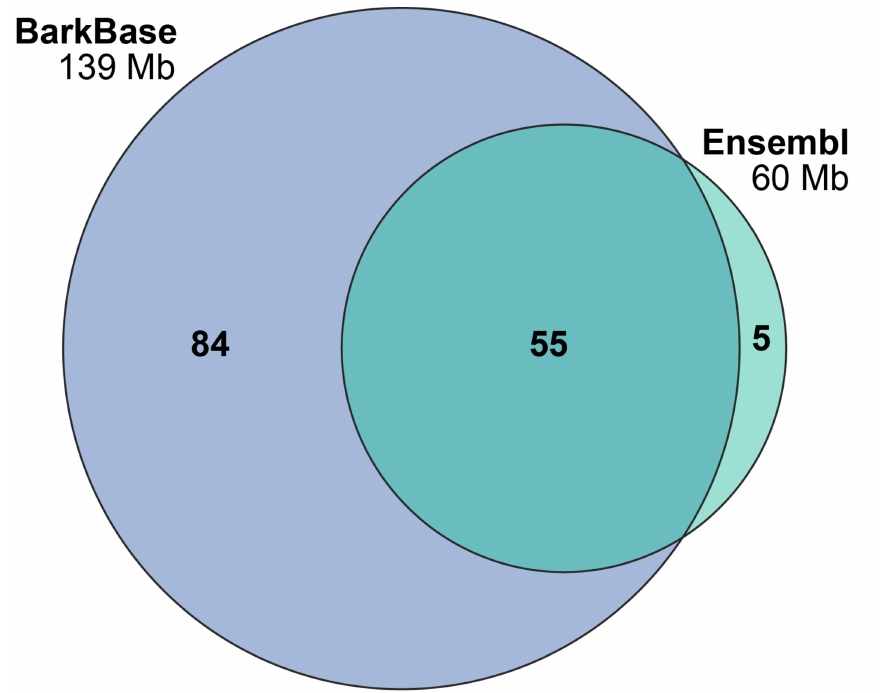
Figure 3. BarkBase captures novel transcripts. Overlapping the transcriptome from BarkBase and Ensembl shows most bases are captured in both datasets. BarkBase contains 84 Mb of transcribed sequence not included in the existing annotation, highlighting its utility to improve the annotation of the canine